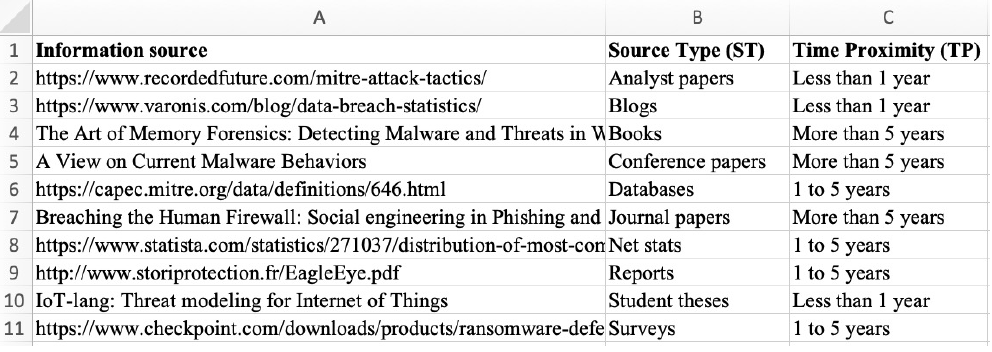
Figure 8. Screenshot of the collected information